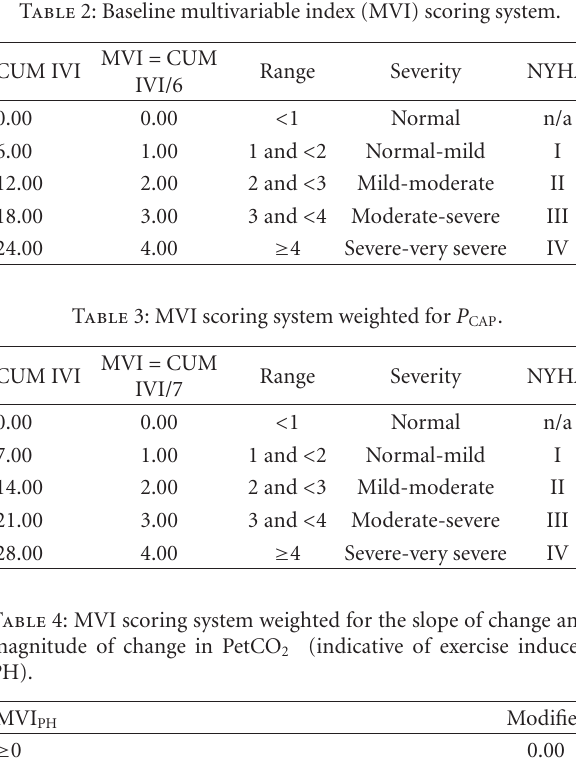
Table 2: Baseline multivariable index (MVI) scoring system. MVI = CUM CUM IVI Range IVI/6